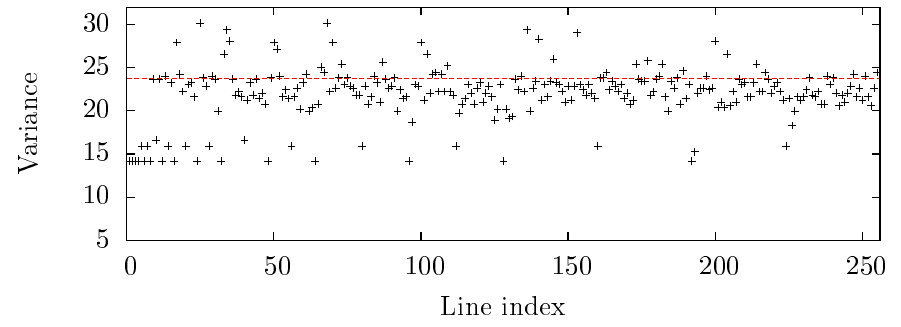
Figure 4: The variance of the lines of the LAT (absolute values) of 𝐻 (BelT). The expected variance is represented with a red dashed